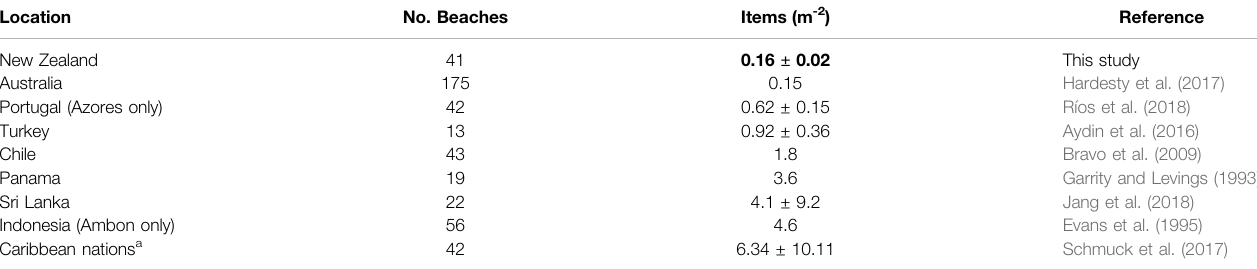
TABLE 1 | New Zealand Beach Debris Density Results from This Study (Spring 2017; numbers in bold) Compared With Other Multi Regional Studies.